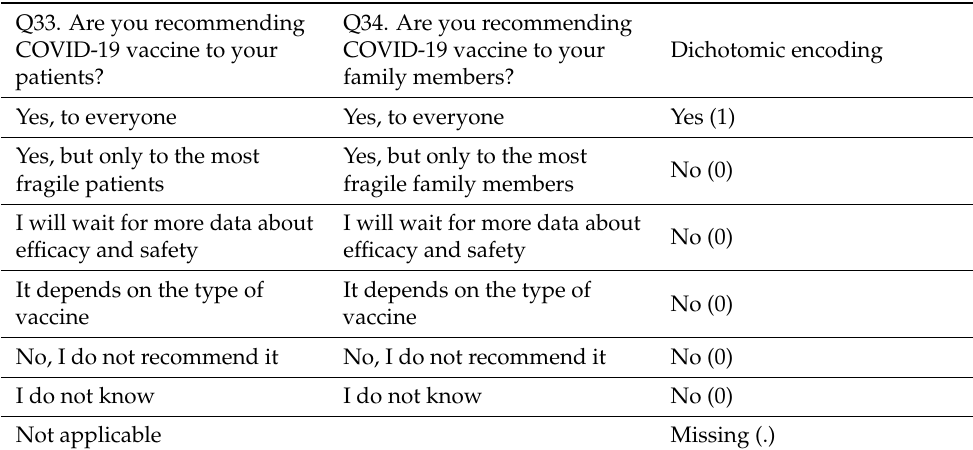
Table 1. Dichotomic encoding for Question 33 and Question 34. Q33. Are you